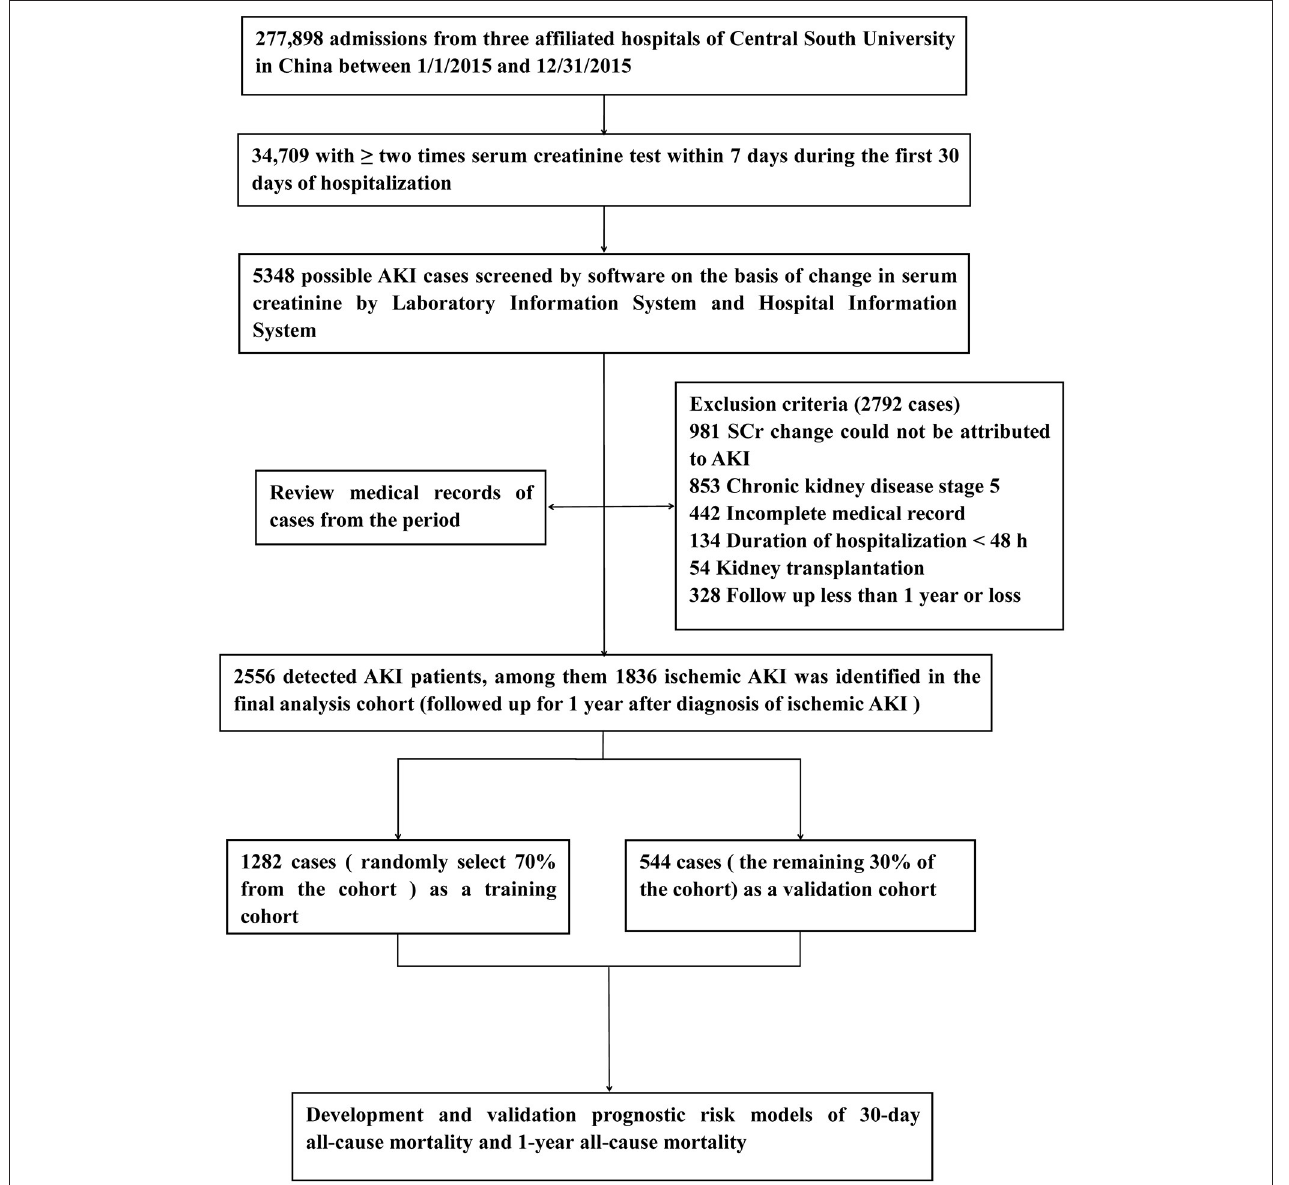
FIGURE 1 | Study flow chart. AKI, Acute Kidney